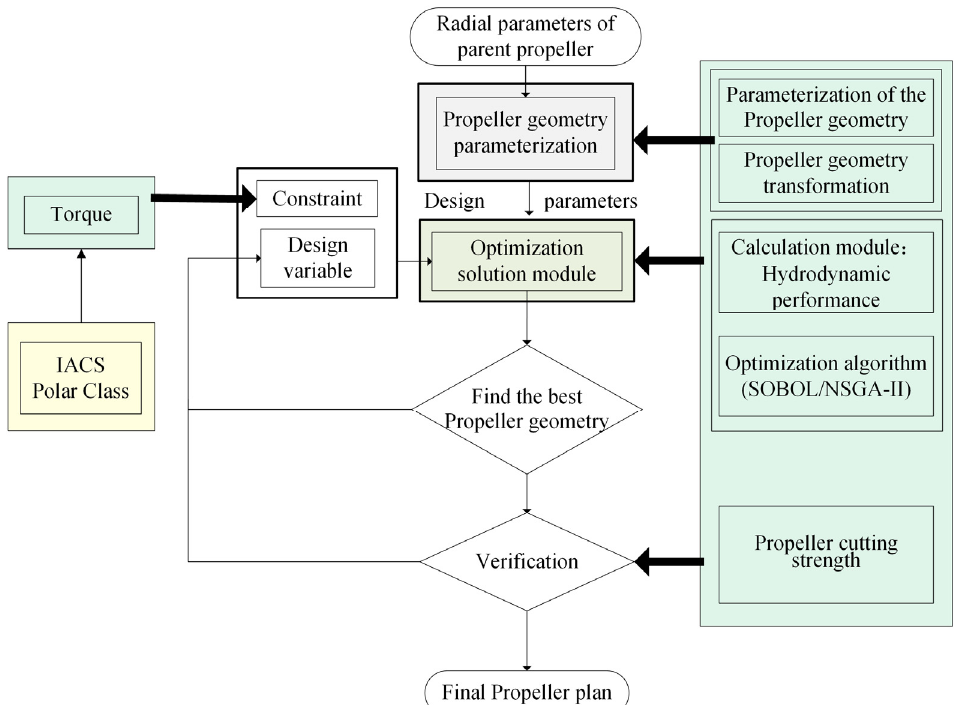
Figure 5. Flow chart of optimized design system.